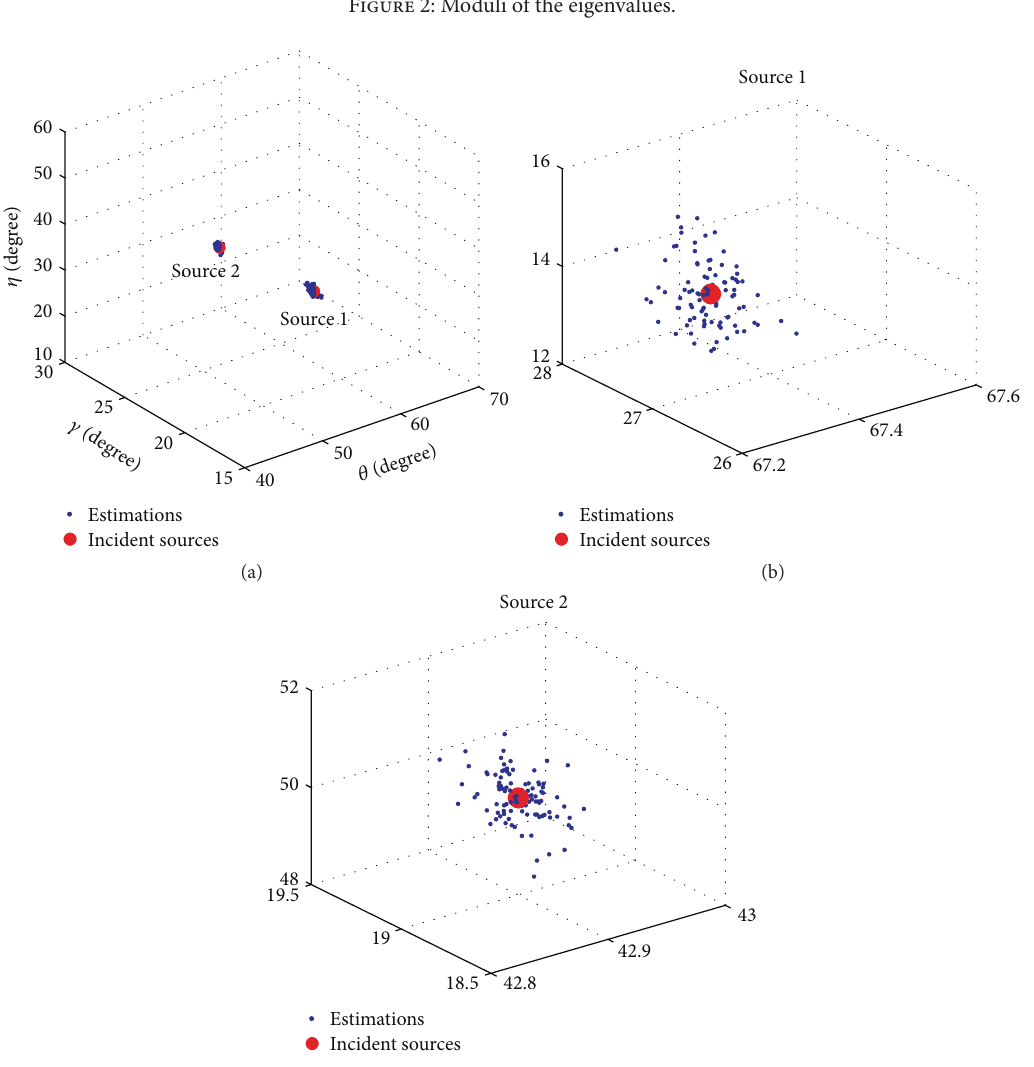
Figure 3: Scatter plot of the uncorrelated sources: (a) global figure; (b) enlarged local scatter plot for the uncorrelated source 1; (c) enlarged local scatter plot for uncorrelated source